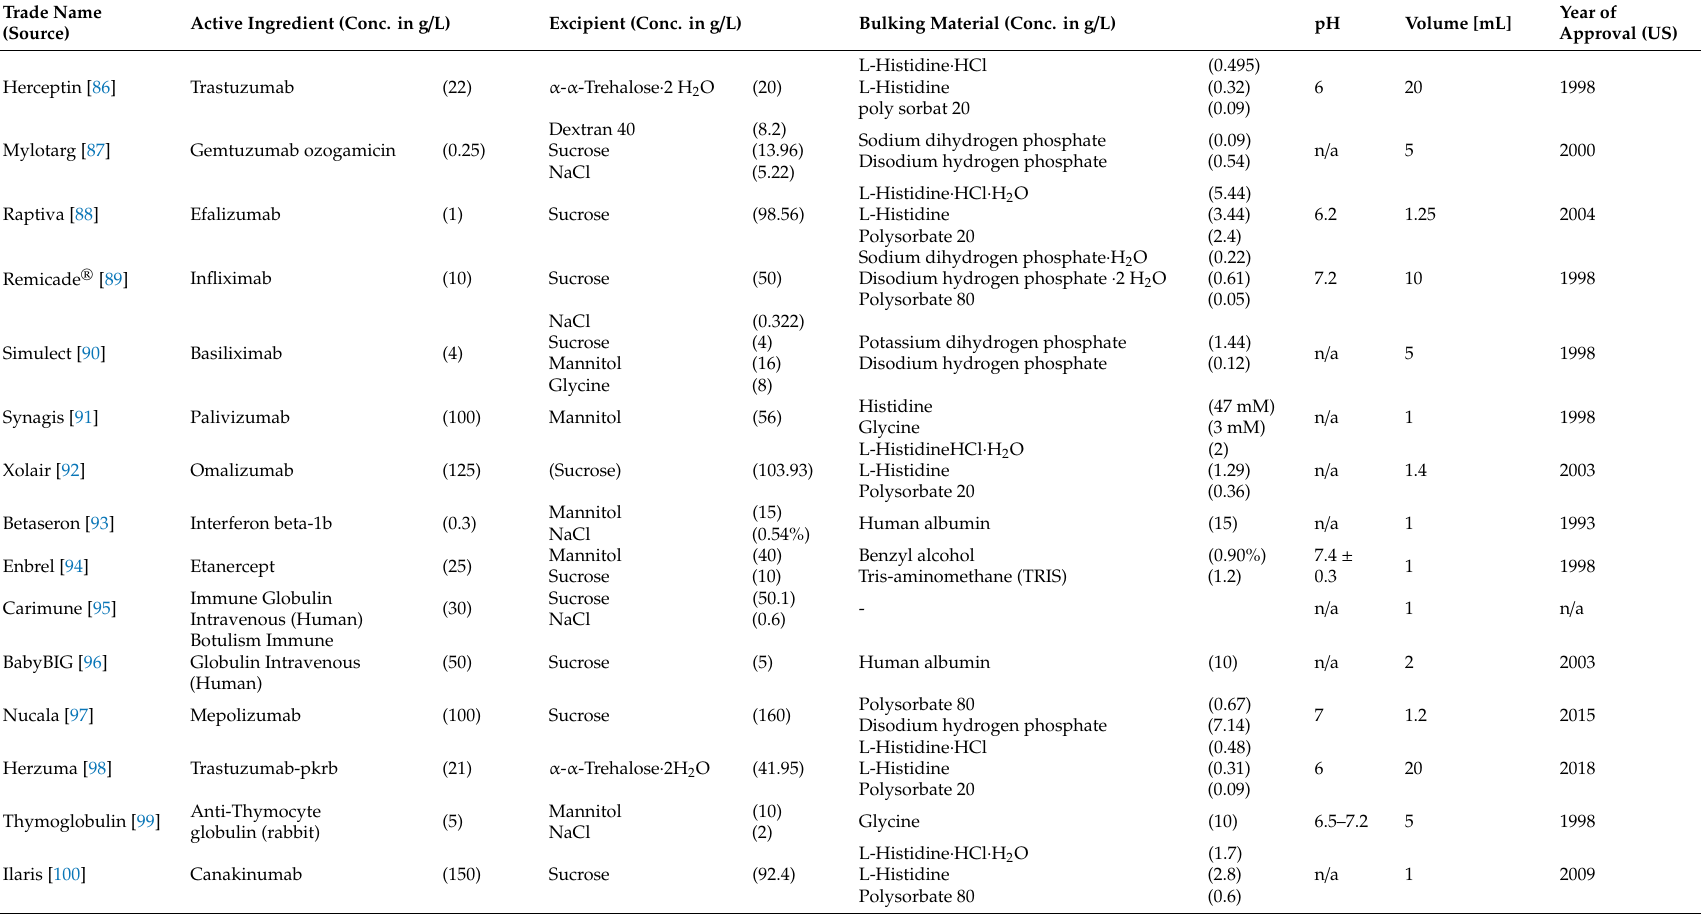
Table A1. Overview of some lyophilized IgG